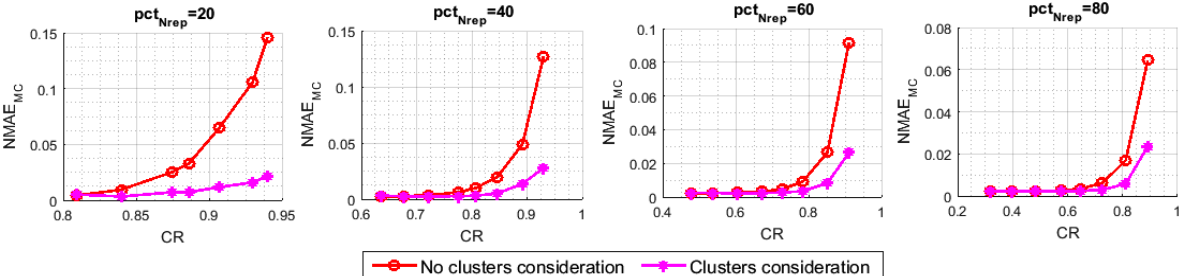
Figure 11. NMAE MC with and without clusters